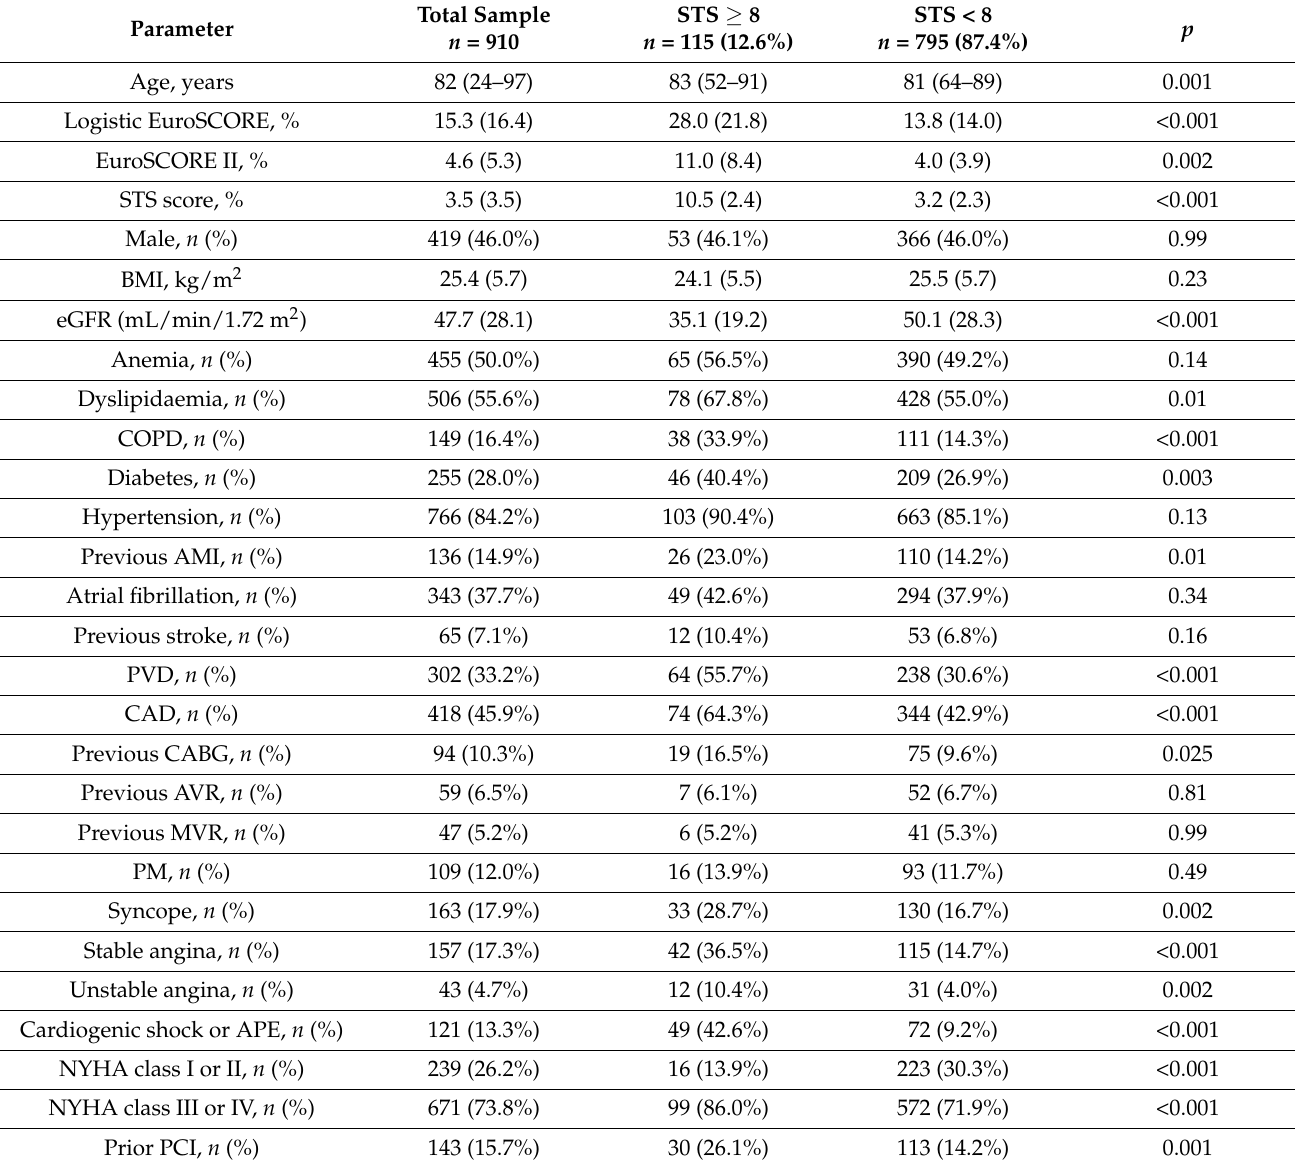
Table 1. Baseline characteristics of study